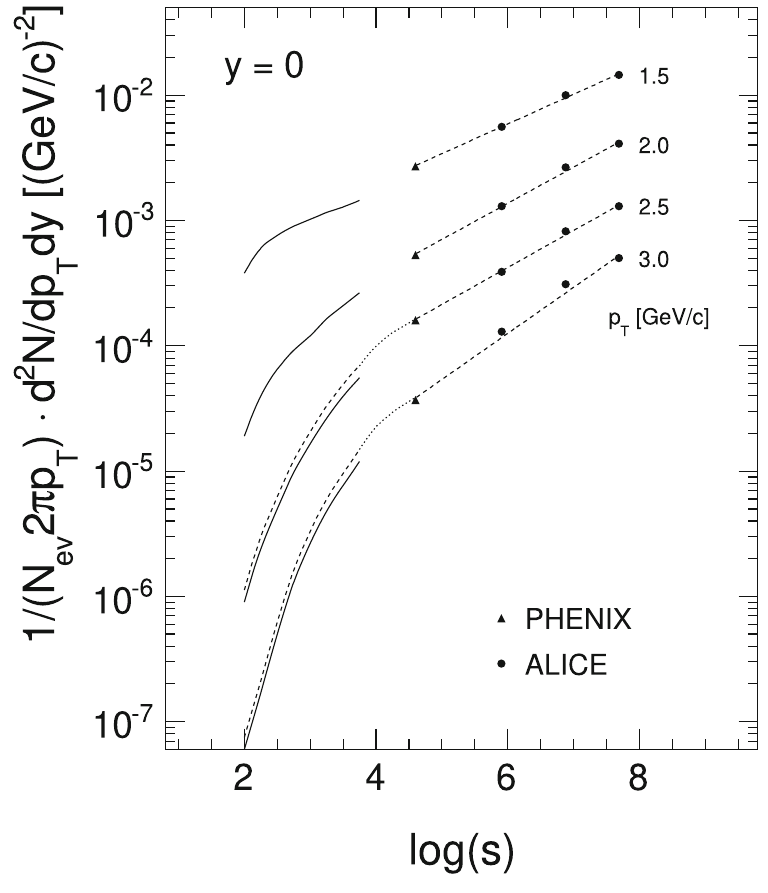
Fig. 88 Invariant π − densities f /σ inel as a function of log ( s ) for p T values between 1.5 and 3 GeV/c showing the reference data as full lines and data from PHENIX and ALICE as broken